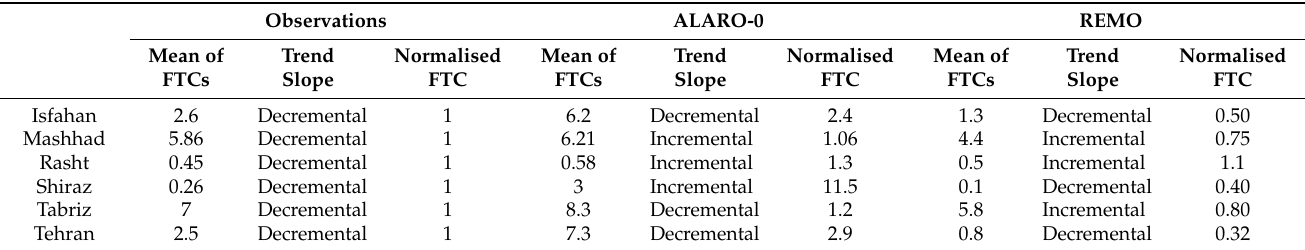
Figure 7. The annual number of FTCs for the models and observations over Mashhad ( a ), Shiraz ( b ), Tehran ( c ), Tabriz ( d ), Isfahan ( e ) and Rasht ( f ) during 1980–2017. Table 3. Model performance for FTC index over six studied stations